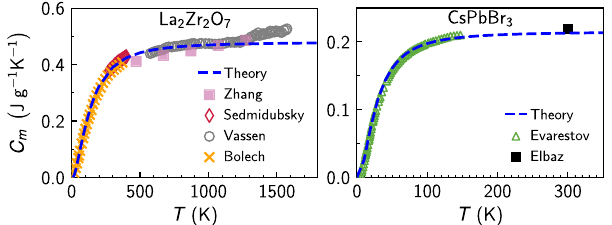
FIG. 10. Specific heat of La 2 Zr 2 O 7 and CsPbBr 3 . Dashed blue lines are theoretical calculations at constant volume and using the bare phonon frequencies. Scatter points are measurements performed at constant pressure. For La 2 Zr 2 O 7 these are taken from Vassen et al. [107], Bolech et al. [183], Zhang et al. [114], and Sedmidubský et al. [184]. For CsPbBr 3 these are taken from Evarestov et al. [185] and Elbaz et al.